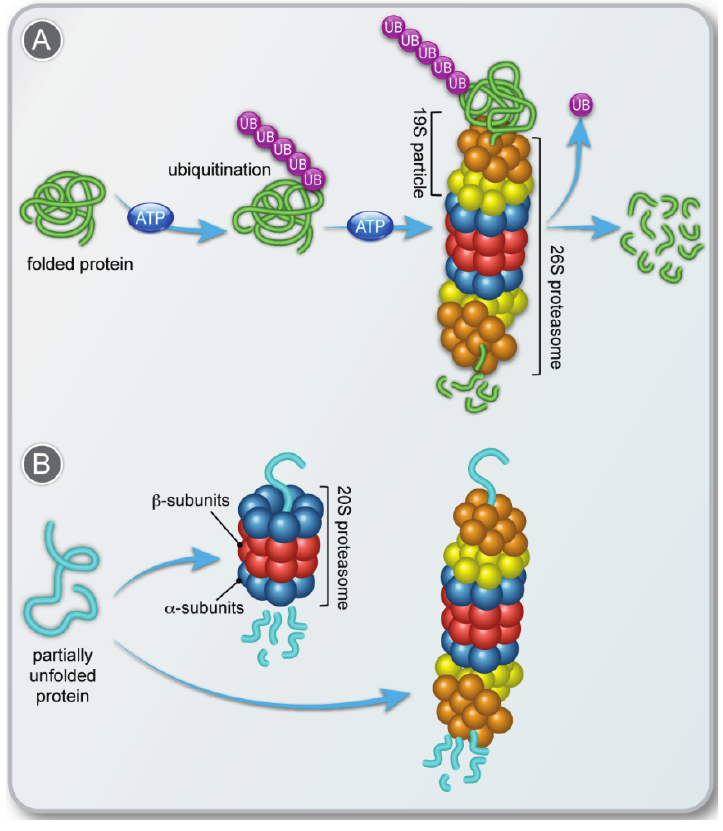
Figure 1. A simplified representation of the ( A ) ubiquitin-dependent 26S proteasome; and ( B ) ubiquitin- and ATP-independent 26S or 20S proteasome, protein degradation pathways.